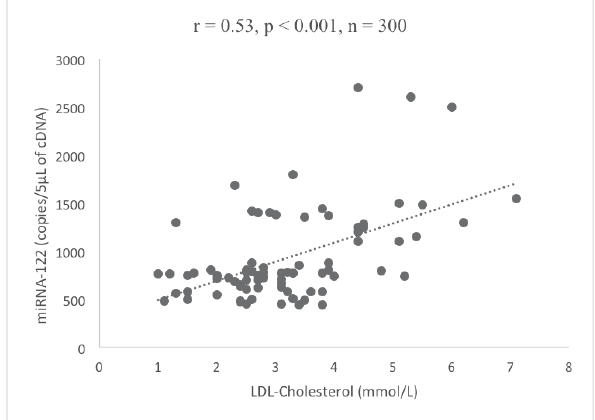
Figure 3: Correlation Graph of miRNA-122 with LDL-Cholesterol There was also a statistically significant positive correlation between miRNA-122 and LDL-Cholesterol, r = 0.53, p < 0.001, n =